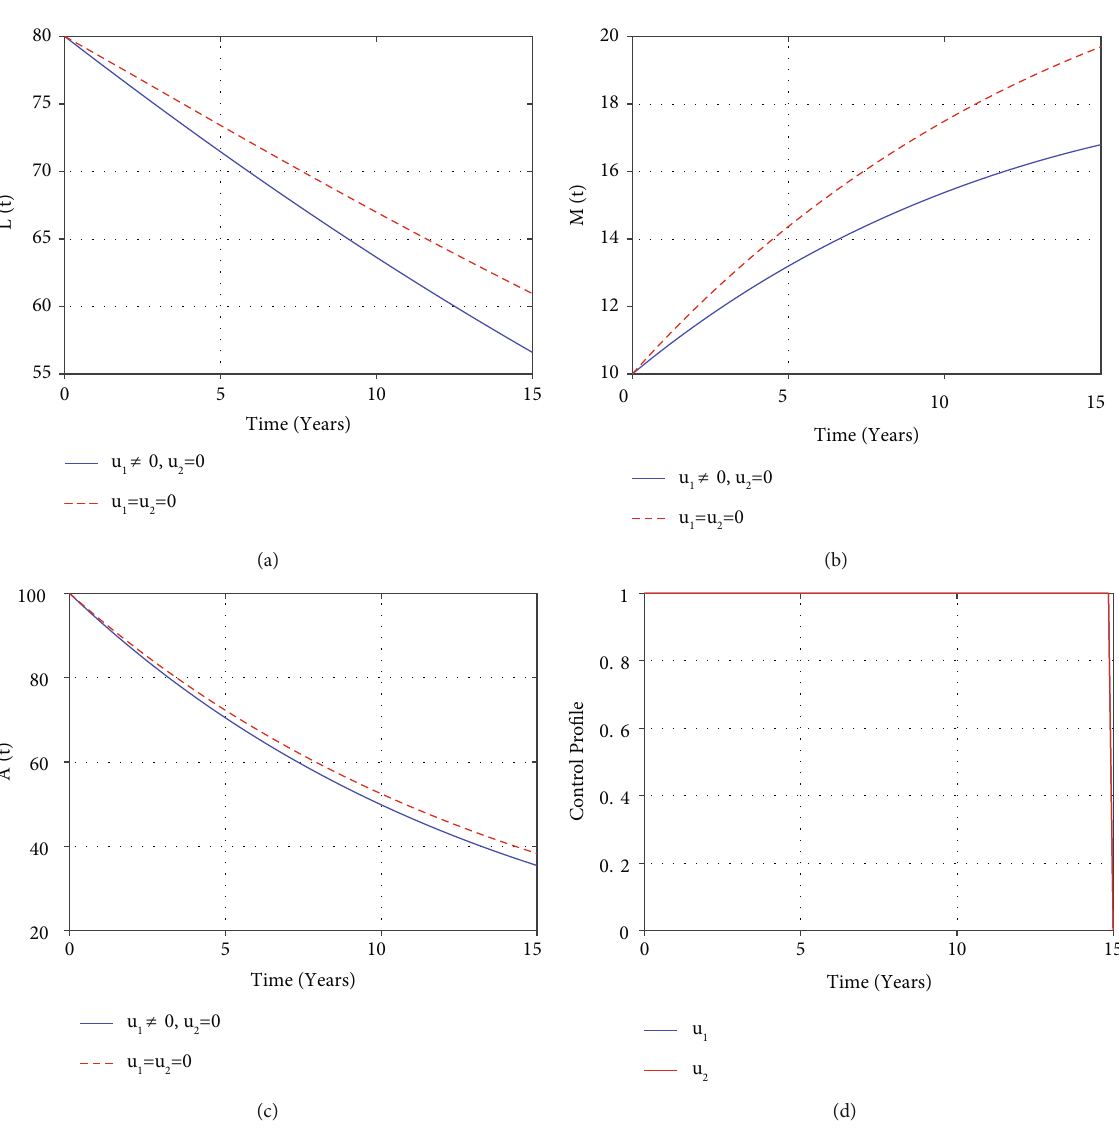
Figure 4: Time series of di ff erent risky population proportions with their corresponding Control pro fi le for implementation of Strategy Strategies